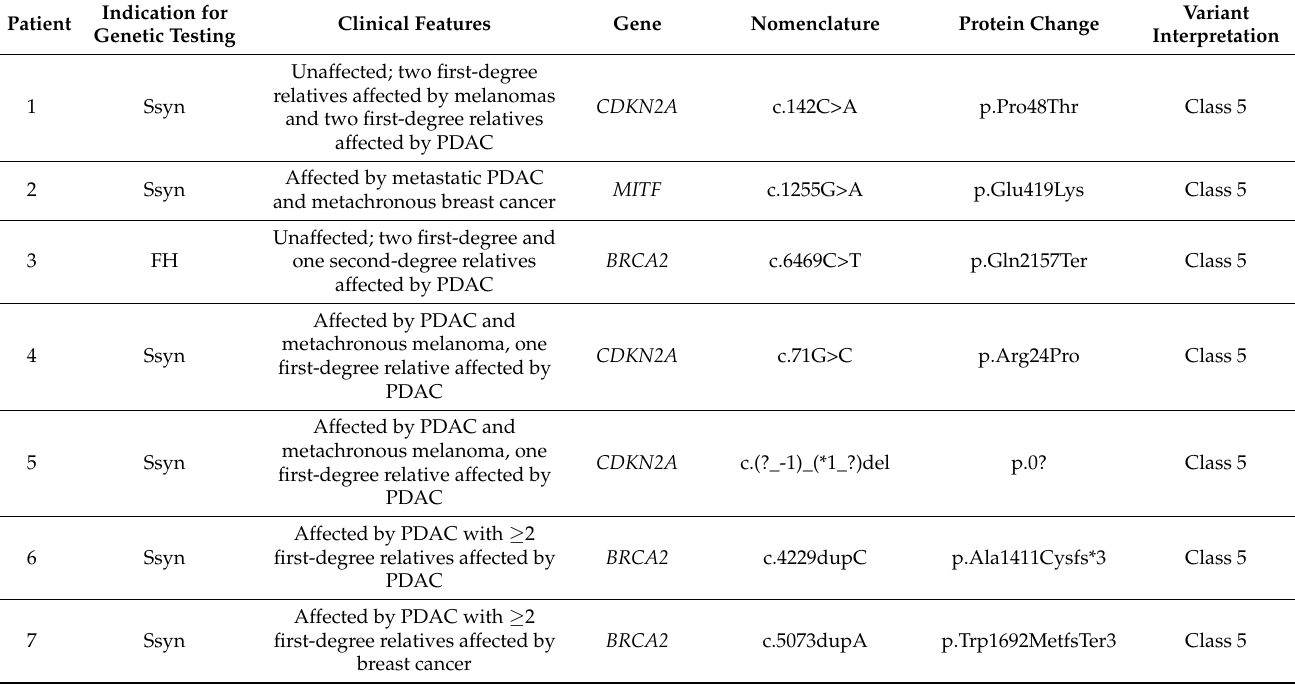
Table 4. Pathogenic variants identified in our